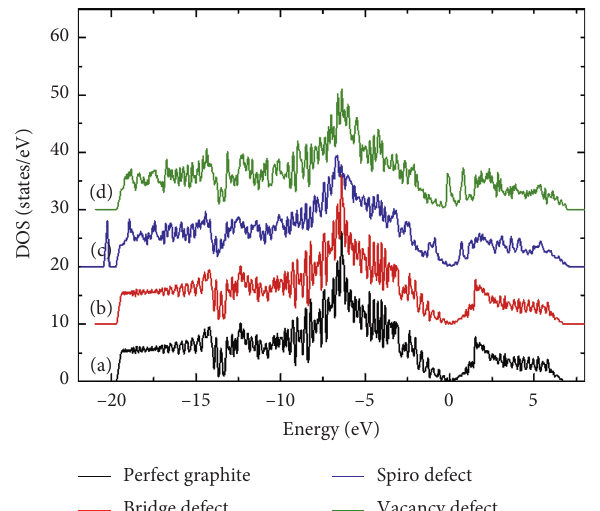
Figure 8: The DOS of matrix graphite with different defects: (a) perfect graphite; (b) “bridge” defect; (c) “spiro” defect; (d) single vacancy defect. The energy is relative to Fermi level ( E f ) at E � 0eV.